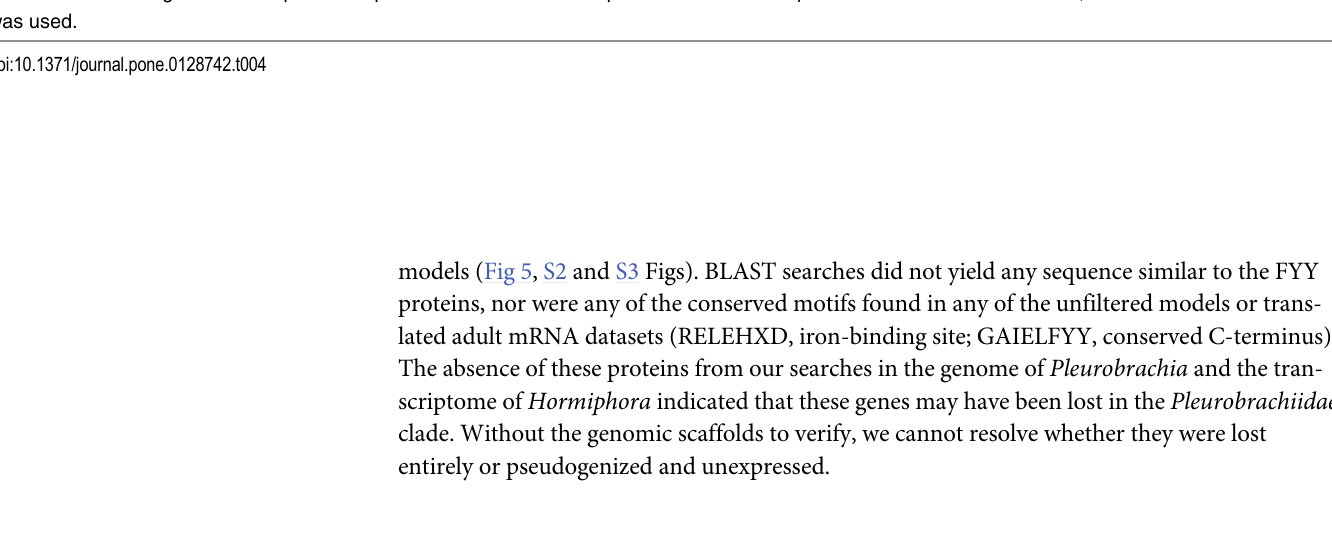
models (Fig 5, S2 and S3 Figs). BLAST searches did not yield any sequence similar to the FYY proteins, nor were any of the conserved motifs found in any of the unfiltered models or trans- lated adult mRNA datasets (RELEHXD, iron-binding site; GAIELFYY, conserved C-terminus). The absence of these proteins from our searches in the genome of Pleurobrachia and the tran- scriptome of Hormiphora indicated that these genes may have been lost in the Pleurobrachiidae clade. Without the genomic scaffolds to verify, we cannot resolve whether they were lost entirely or pseudogenized and unexpressed.